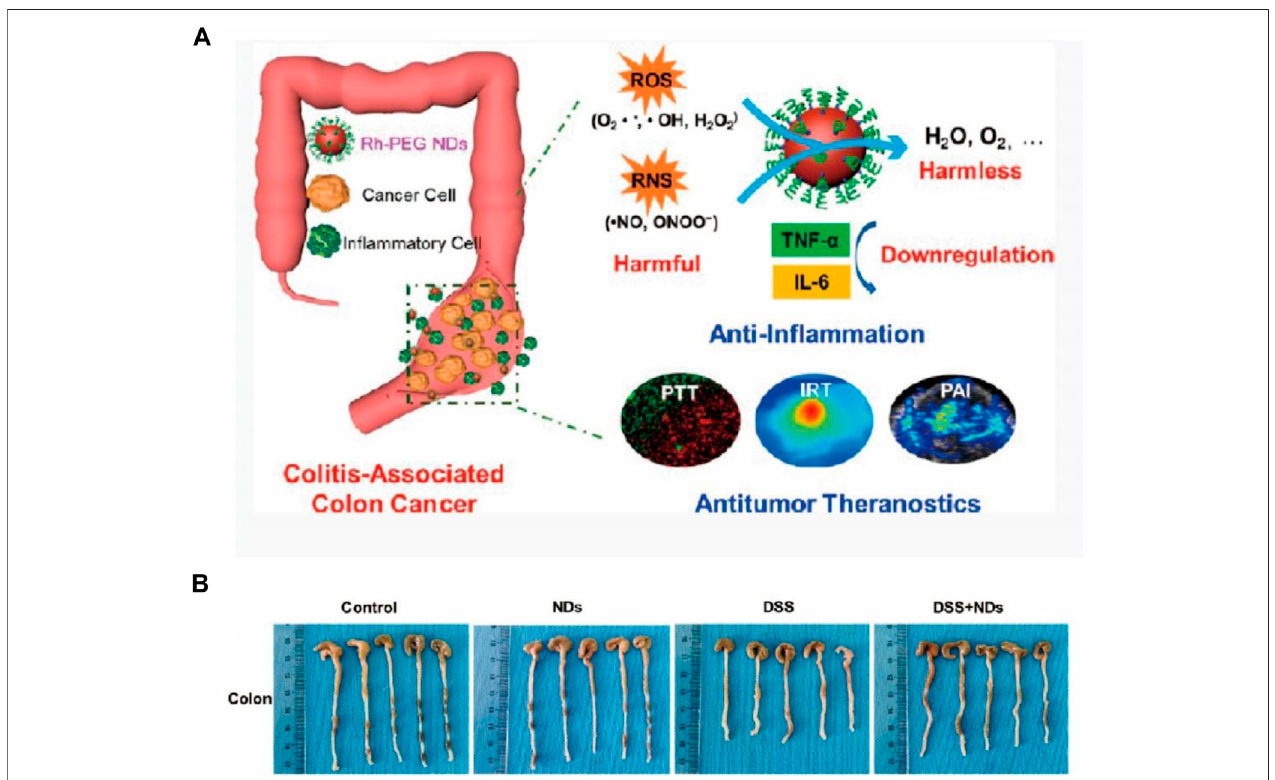
FIGURE 3 | (A) Schematic of PEG-coated ultrasmall rhodium nanodots with RONS eradicating and photothermal activities for IBD and tumor theranostics in vivo . (B) Photographs of colons of various groups showing the anti-in fl ammatory treatment of colitis. Reproduced from Coussens and Wern (2002) with permission from the American Chemical